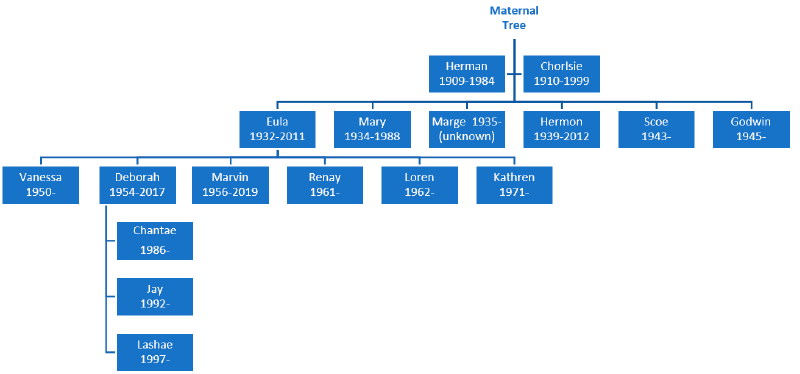
Figure A1. Eula Mae’s abridged family tree (note: some names have been altered for anonymity).